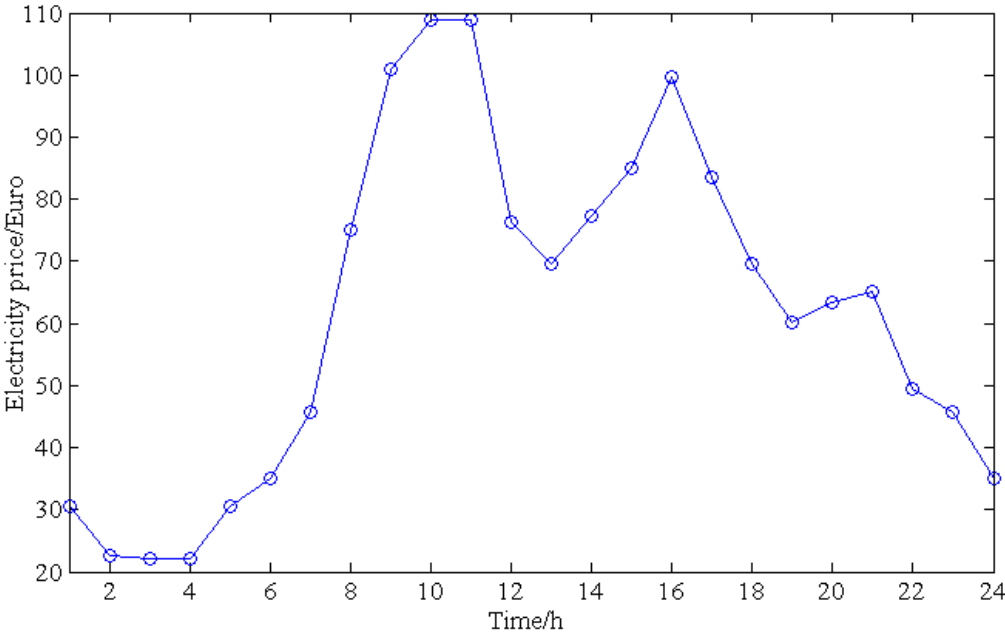
Figure 13. The hourly price of external purchased electricity.